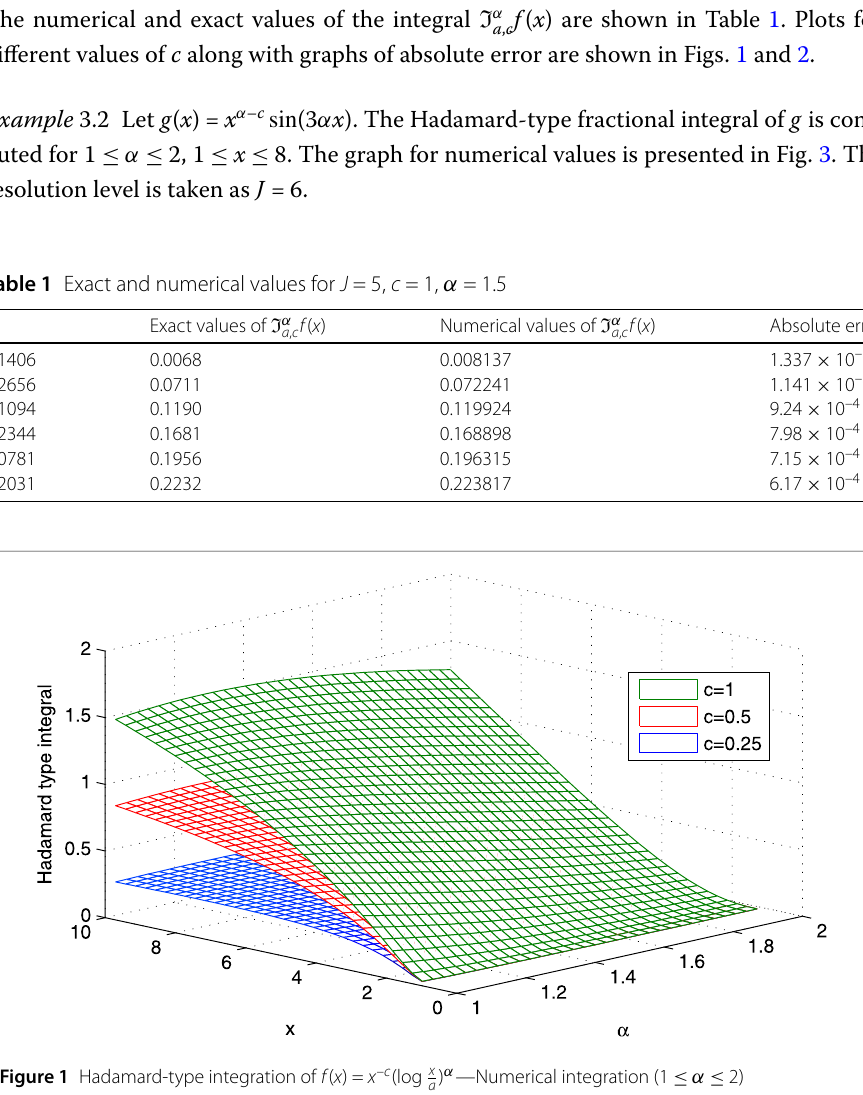
Figure 1 Hadamard-type integration of f ( x ) = x – c (log x